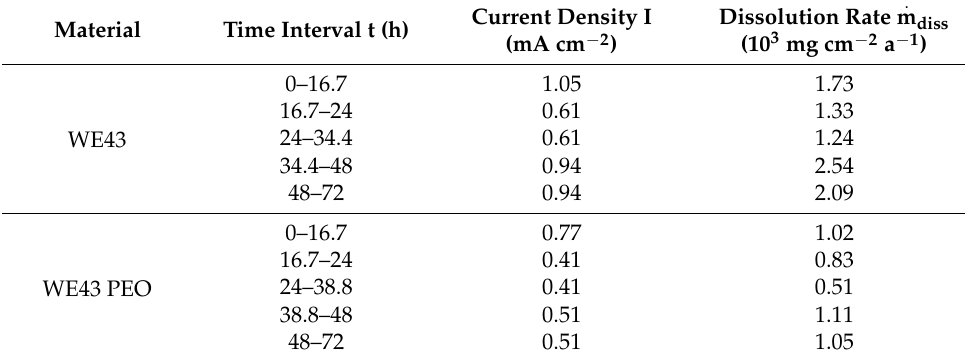
Table 2. Immersion tests with galvanostatic polarization on Mg WE43 and WE43 PEO in 0.9% NaCl solution at 36.5 ◦ C.